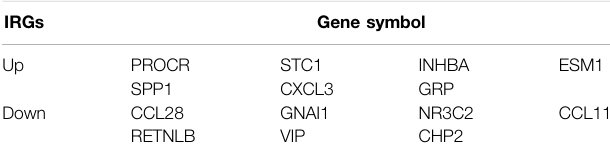
TABLE 2 | Up- and downregulation of 14 differentially expressed IRGs in the model. IRGs